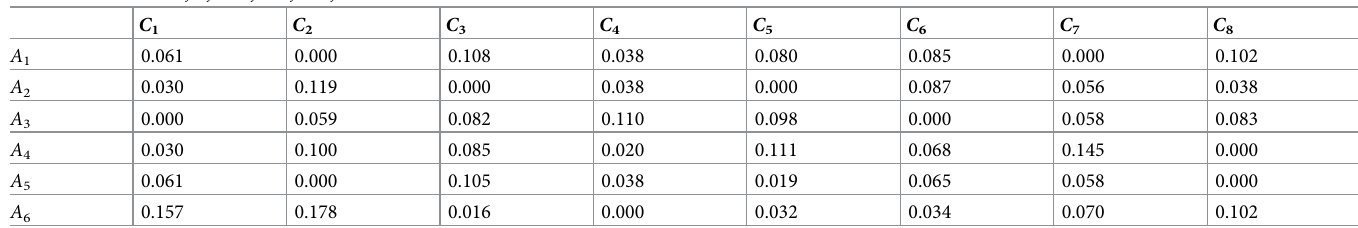
Table 13. Scores of w